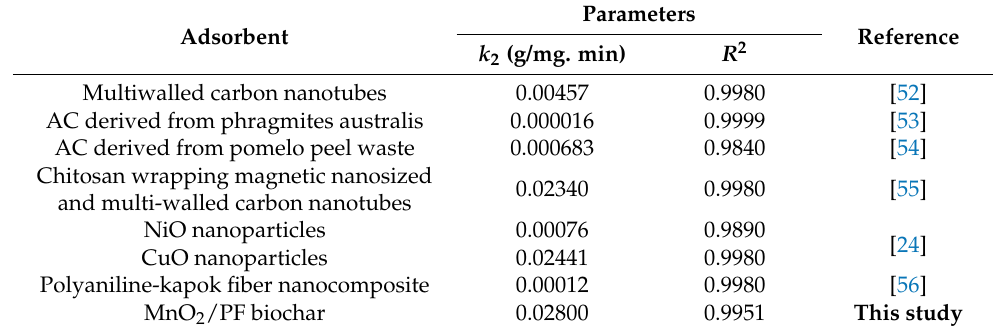
Table 4. Previously reported kinetic studies of various adsorbents for